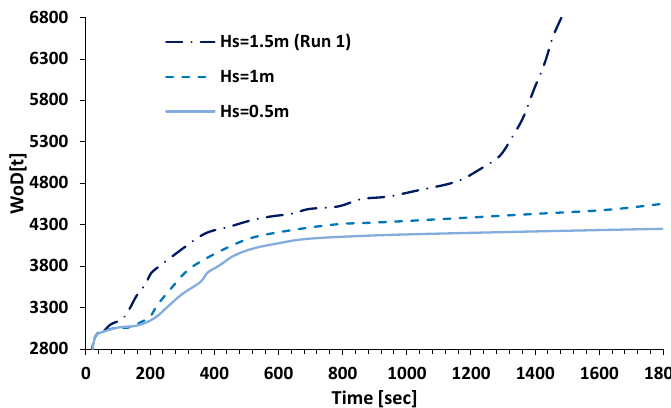
Figure 12. Floodwater on deck time-histories for varying Hs.